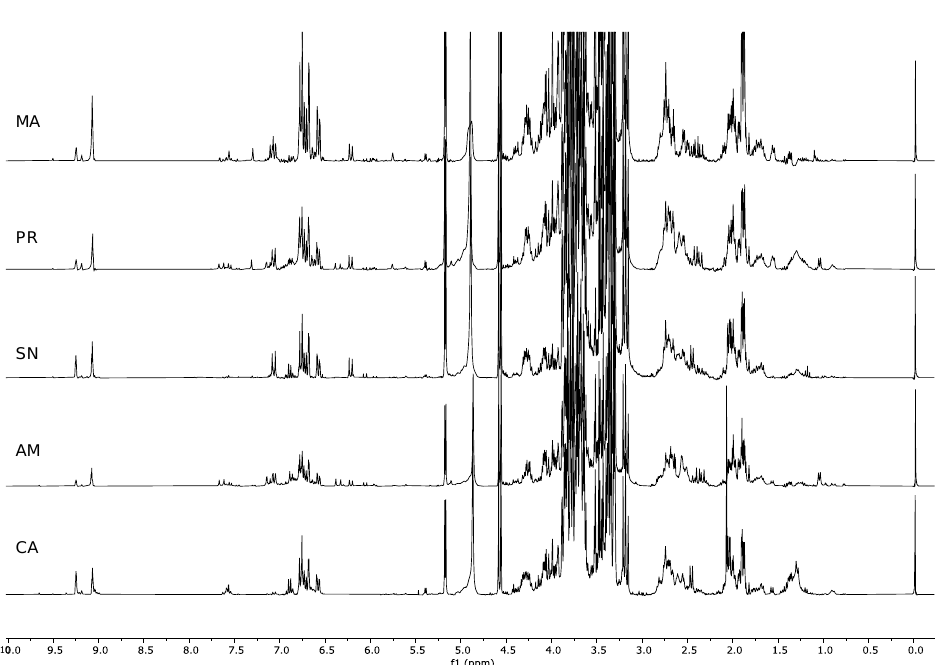
6 of 16 Figure 3. 1 H-NMR spectra of Group I: Ricippudda (RI), Salella (SA), Rotondella (RT), and Nostrale (NO). All of the other cultivars were characterized by a very rich aromatic region. The samples in the upper-right quadrant of the PCA score plot (GroupII, Figure 1) were characterized by signals in the aromatic and olefinic regions, but most notably by the presence of metabolites characterized by an aldehydic signal at δ H 9.09. Although in